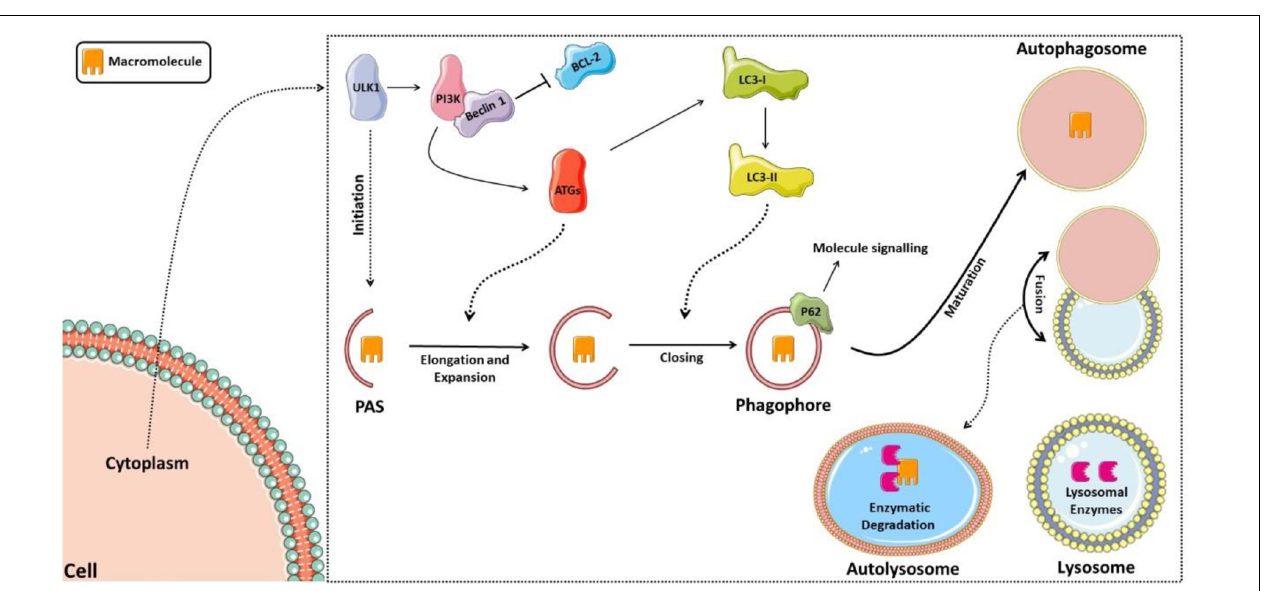
FIGURE 2 | Schematic model of the autophagic pathway. The process starts with activation of the ULK1 complex, then activation of phosphatidylinositol 3-kinase (PI3K), which forms a complex with Beclin 1 after it dissociates from lymphoma B cell 2 (BCL-2). Thus, the complex formed activates several proteins of the autophagic family (ATGs), which participate in the elongation of the phagophore and activation of the LC3-I protein (light chain 3 of protein 1 associated with microtubules), forming LC3-II, responsible for closing the phagophore and interacting with the p62 protein, signaling the material to be degraded. The